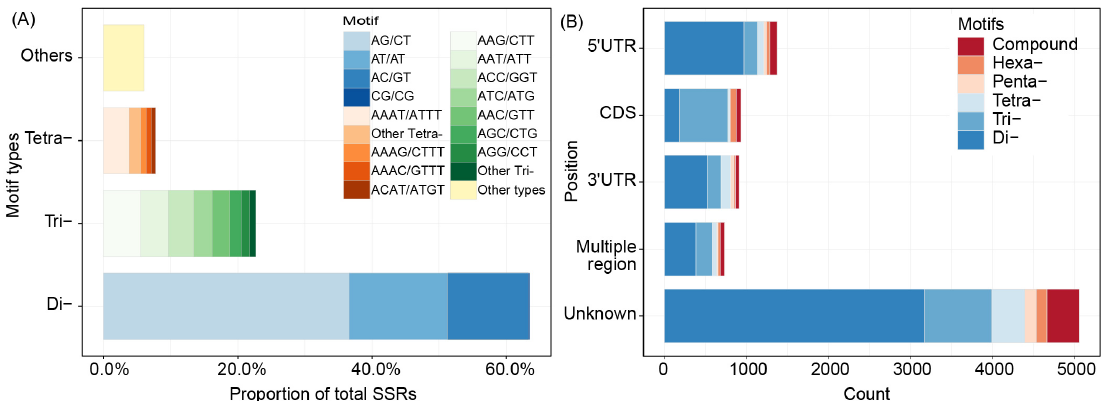
Figure 1. Distribution of di ff erent repeat motifs and positions of simple sequence repeats (SSRs) in unigenes. ( A ) Proportion and distribution of each type of motif in dinucleotide (Di-), trinucleotide (Tri-), tetranucleotide (Tetra-) and other (i.e., Penta-, Hexa- and compound) repeats. In the legend, ‘other Tri-’ consists of ACG / CGT (0.26%), ACT / AGT (0.26%) and CCG / CGG (0.42%), and ‘Other Tetra-’ consists of 26 types of Tetra- repeats, the most abundant of which are AATC / ATTG (0.22%) and AGGG / CCCT (0.22%). ( B ) Abundances of six motifs in di ff erent unigene positions. Two types of SSRs were located in multiple regions. One of these SSRs was located across two 5 (cid:48) UTRs, a coding sequences (CDS) and a 3 (cid:48) UTR; another was located in multiple CDSs in one unigene. The SSR locations di ff ered from each other. Unknown refers to the SSRs without matching